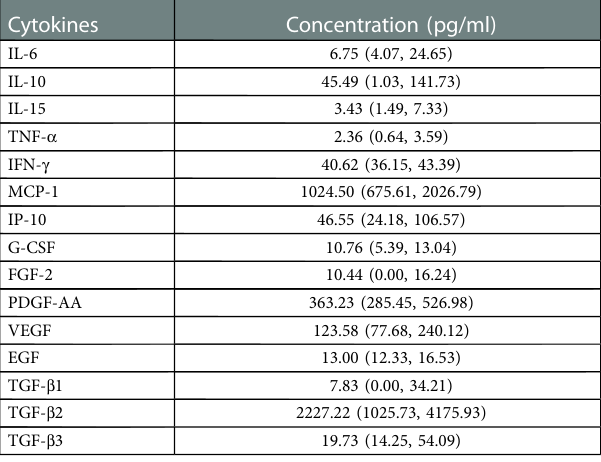
TABLE 4 Median and 25th to 75th interquartile range of the concentrations of cytokines in the aqueous humor samples collected at the primary